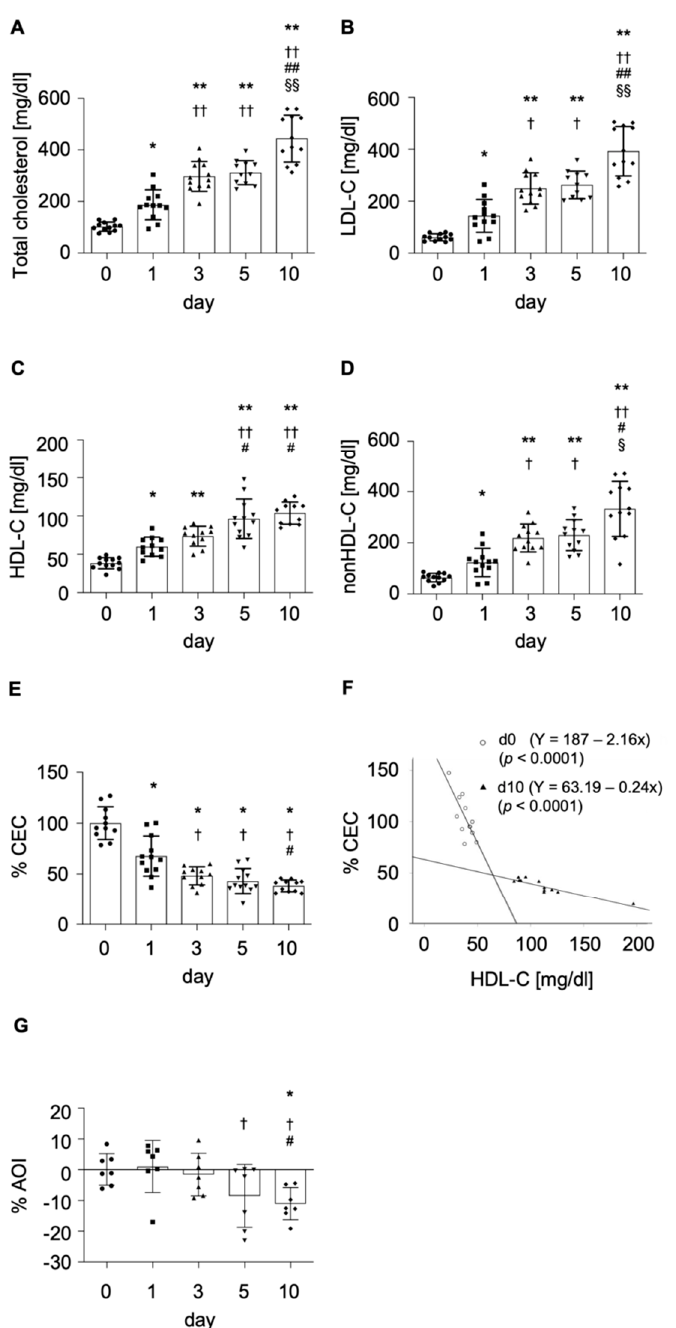
Figure 1. Diet ‐ induced hypercholesterolemia onset increases lipid parameters while HDL function is impaired. Progression of plasma lipid parameters including total cholesterol ( A ), LDL ‐ C ( B ), HDL ‐ C ( C ), non ‐ HDL ‐ C ( D ), and HDL functional measures cholesterol efflux capacity (CEC) from macrophages to HDL ( E ), and antioxidant capacity ( G ) are depicted during the first 10 days of HC diet. The correlation between cholesterol efflux capacity and HDL ‐ C levels (d0 and d10 ( F ) is shown with linear regressions. Individual values are depicted with bars representing the mean ± SD over time. Shapiro–Wilk test confirmed normality (alpha = 0.05), and data were analyzed by one ‐ way ANOVA with Tukey’s multicomparison test and considered significant with a p ‐ value < 0.05. * p < 0.05, ** p < 0.0001 in comparison to day 0; † p < 0.05, †† p < 0.0001 in comparison to day 1; # p < 0.05, ## p < 0.0001 in comparison to day 3; §§ p < 0.0001, § p < 0.05 in comparison to day 5. LDL ‐ C: low ‐ density lipoprotein cholesterol; HDL ‐ C: high ‐ density lipoprotein cholesterol; CEC: cholesterol efflux capacity; AOI: antioxidant index.